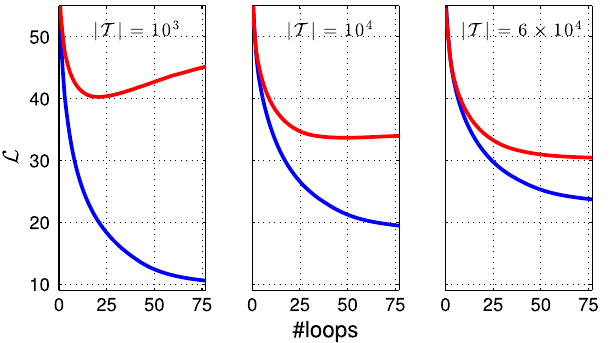
FIG. 7. Evolution of the average negative log-likelihood L for both training images (blue, bottom lines) and 10 4 test images (red, top lines) during training. From left to right, the numbers of images in the training set j T j are 10 3 , 10 4 , and 6 × 10 4 , respectively.